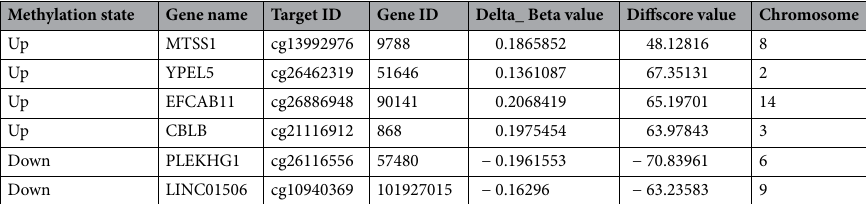
Table 2. Differential DNA methylation sites information between CD penetrating intestinal mucosal tissue with non-penetrating intestinal mucosal